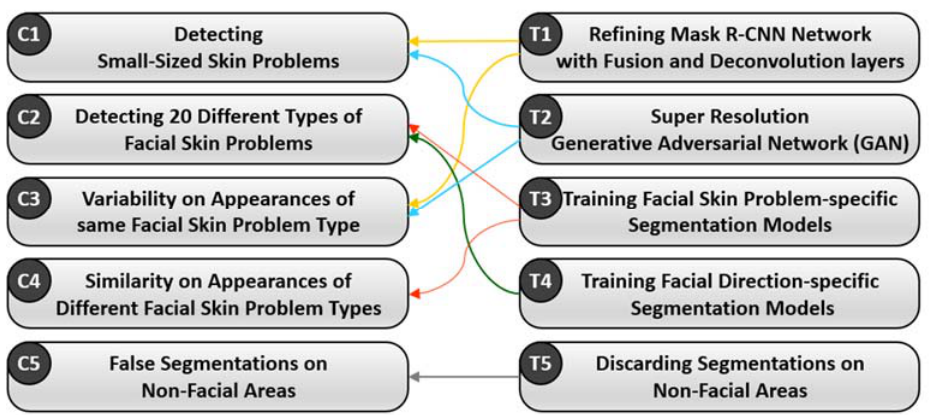
Figure 5. Effectiveness of the tactics on remedying the technical challenges.